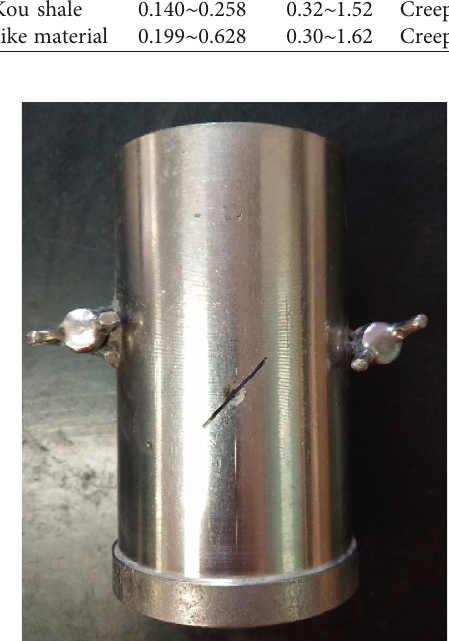
Figure 1: The mould of specimen.